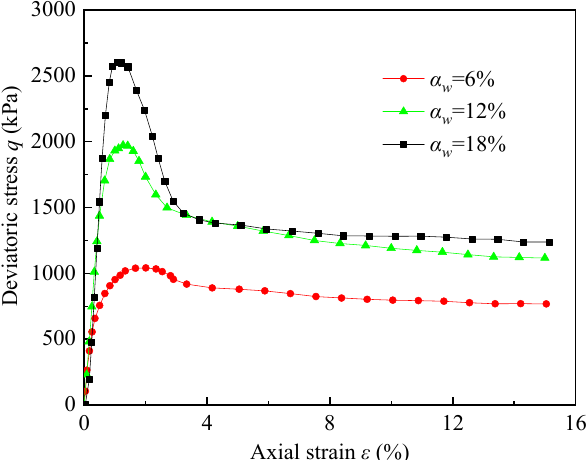
Figure 4. Stress–strain curves of the cemented soil under a 400 kPa confining pressure (curing time: 28 days).